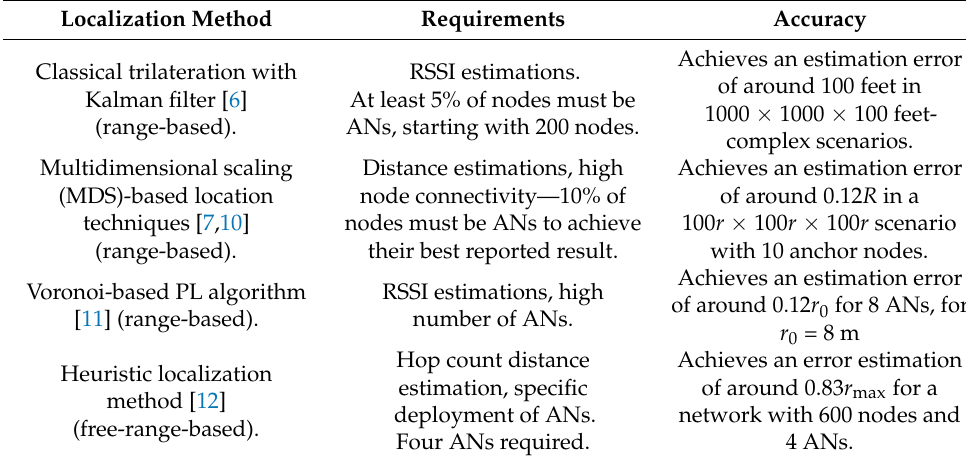
Table 1. Summary of localization